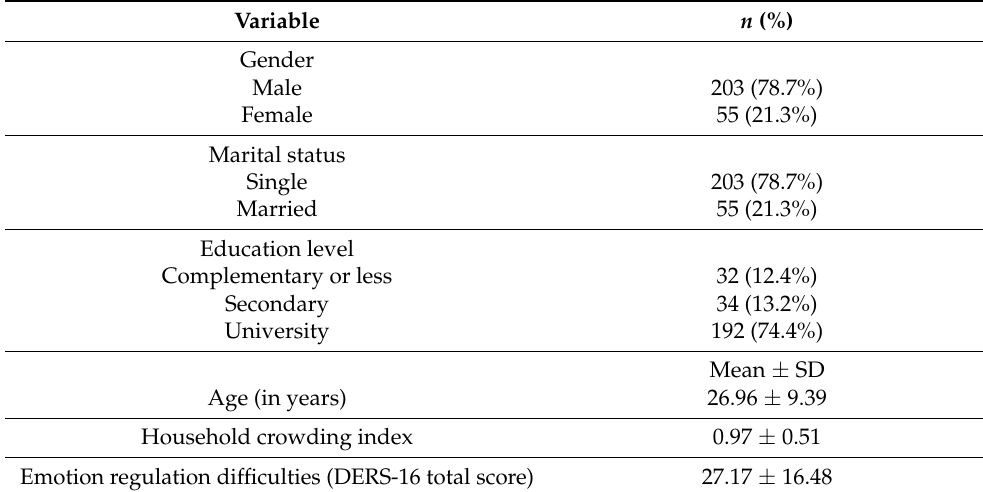
Table 1. Sociodemographic and other characteristics of the participants ( n =